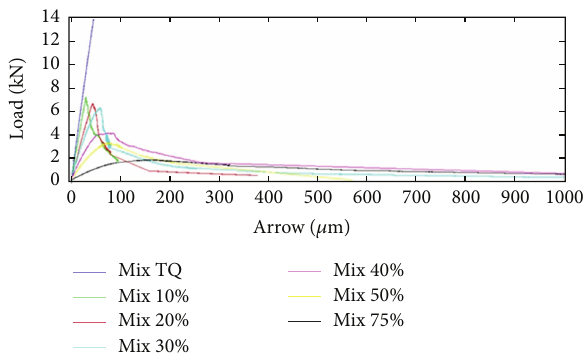
Figure 13: Flexure load-deflection primary curves for rubber cement composites.